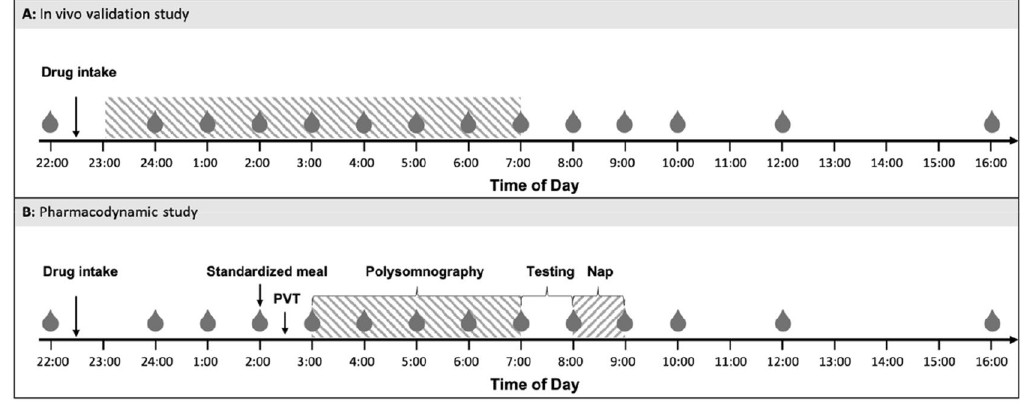
Figure 1. Illustration of the study procedures of the in vivo validation study ( A ) and the pharmacodynamic study ( B ). Timepoints of blood withdrawal are indicated as grey drops (drop symbols). Sleep episodes are highlighted as hatched areas. In both studies, sleep was continuously recorded by polysomnography. In the pharmacodynamic study, participants were kept awake until 3:00. Immediately after awakening from a restricted 4-h nocturnal sleep episode (at 07:00), volunteers performed a 1-h testing battery (referred to as “Testing”) to quantify behavioral, cognitive, emotional and physiological markers of sleep inertia. At 8:00, the participants were given a 1-h nap opportunity, while the latency to fall asleep and the sleep profile were recorded with polysomnography. Sleep inertia assessment, CAR measurements and physiological sleepiness testing were only performed in the pharmacodynamic